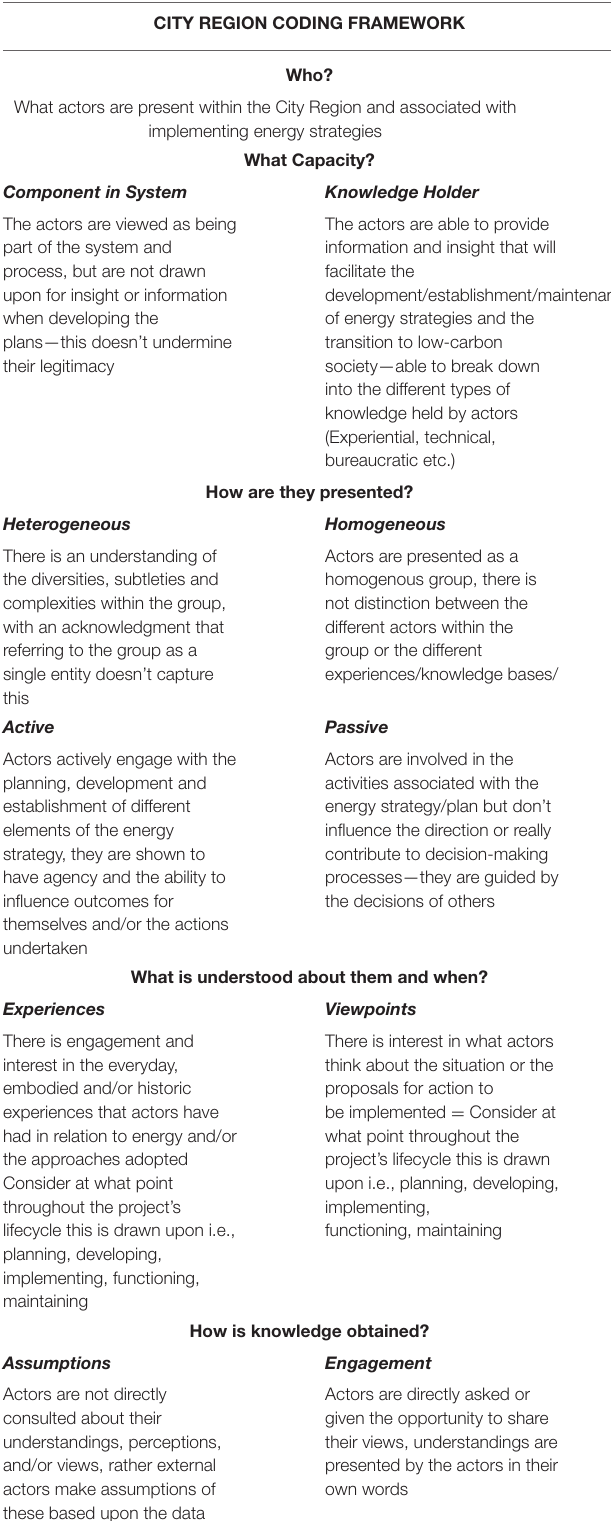
TABLE 1 | A breakdown of the analytical framework used to support the analysis of each city region’s approach to a city region low-carbon transition, developed by the